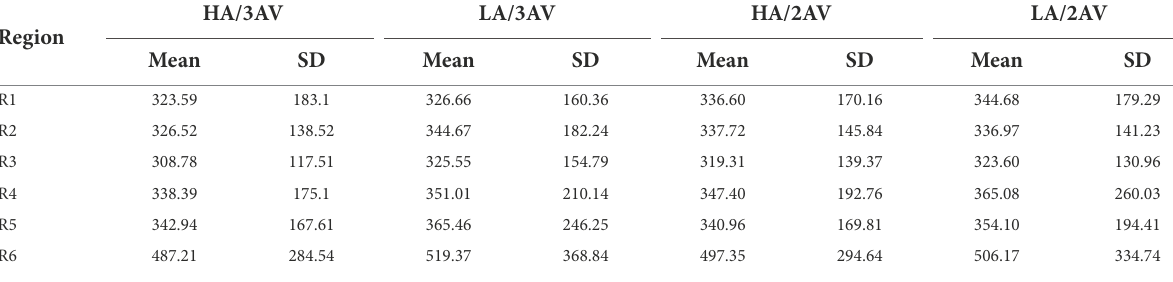
TABLE 3 The mean and SD of the trimmed raw reading times [ms] per region per